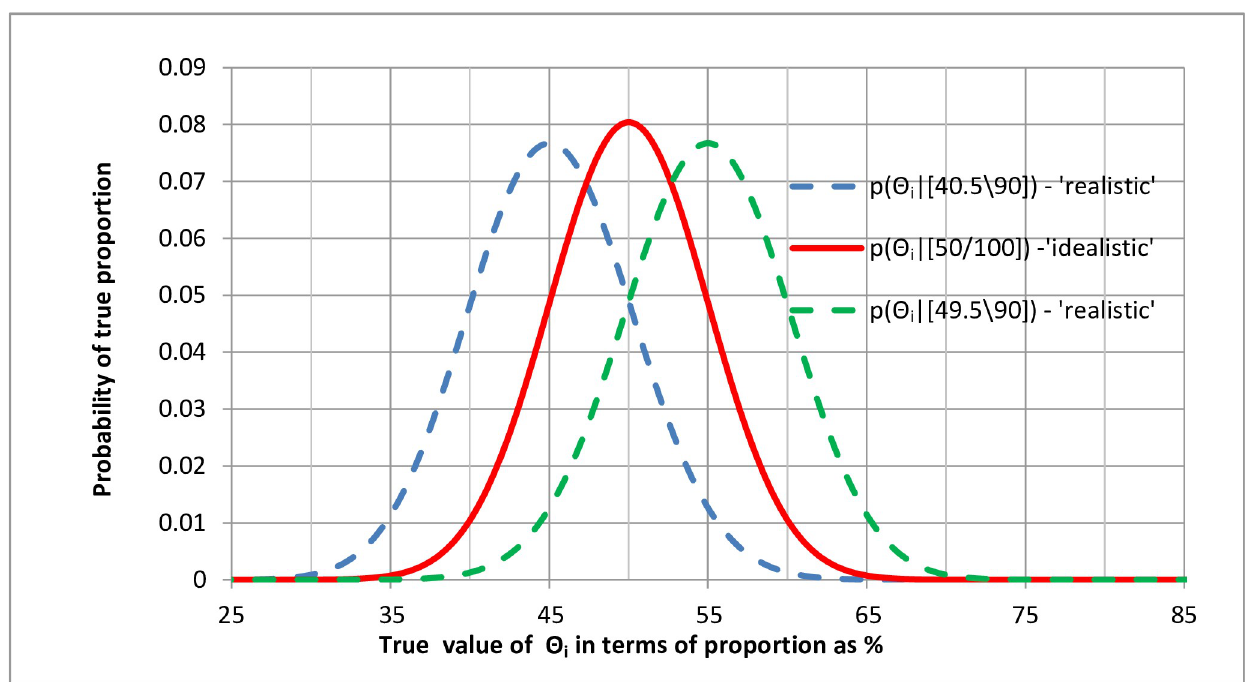
Fig 7. Taking into account the probability of impeccable reproducibility for an observation [50\100].